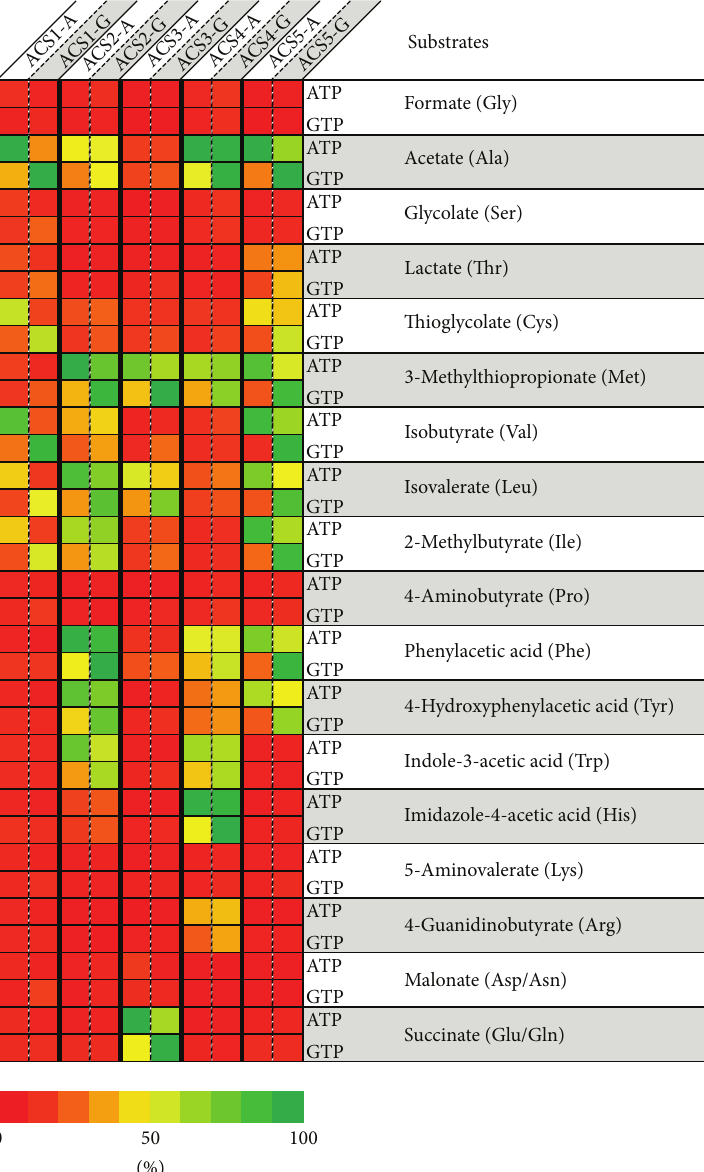
at 80 ∘ C as it is extremely unstable at the assay temperature and direct comparisons were not possible. Similarly, the